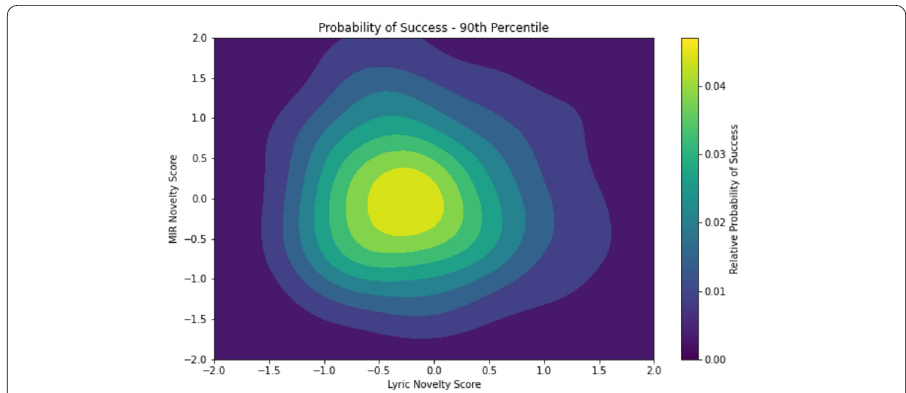
Figure 6 Relative probability of success in reaching the 90th percentile of total weeks on chart for different combinations of MIR and lyric novelty scores. We see that the probability decreases as either score moves away from the value that provides the optimal degree of differentiation within its modality. Since the relative probability values are a summation of probability estimates of a generated data set, they are dependent on the total number of data points generated for our sample, and should not be treated as an absolute probability